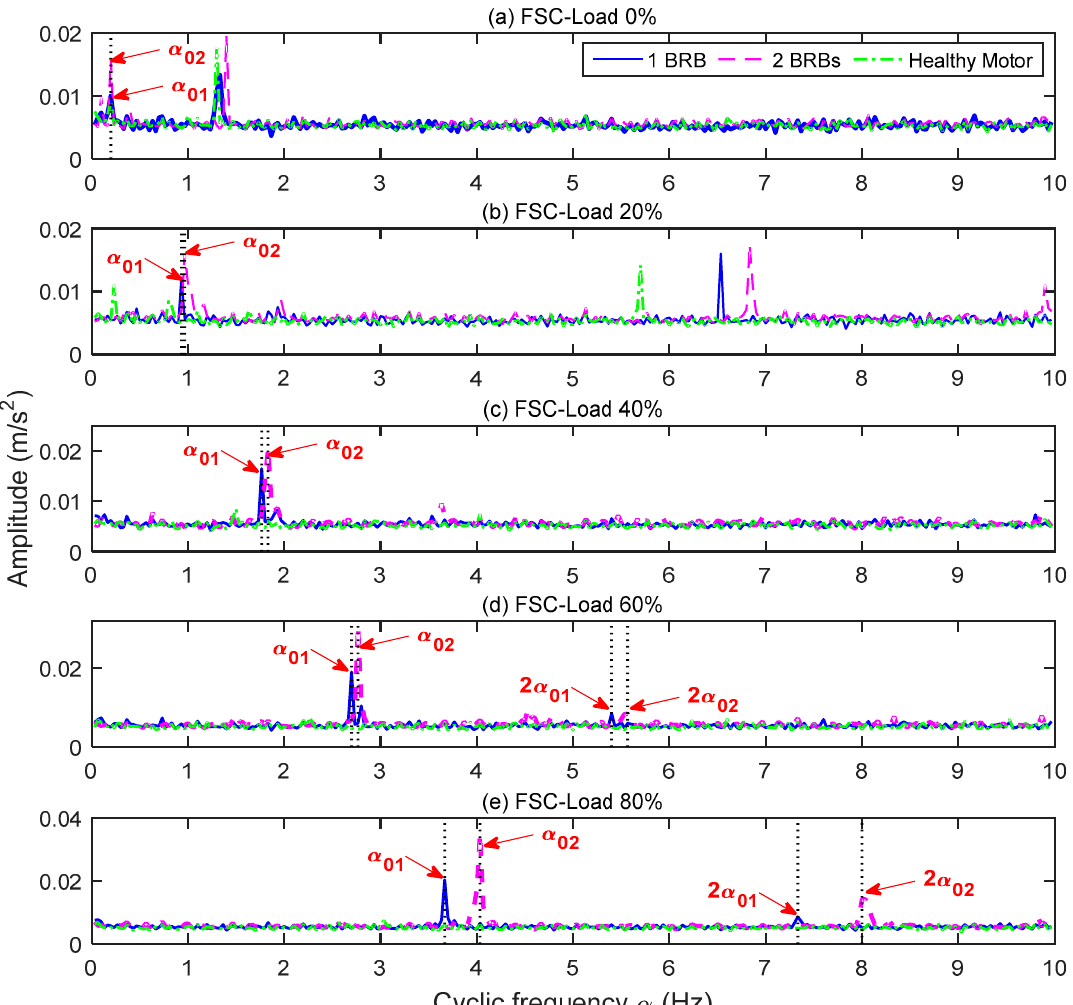
Figure 9. The characteristic frequencies of α 01 and α 02 for 1 BRB and 2 BRBs based on FSC method at ( a ) 0% load, ( b ) 20% load, ( c ) 40% load, ( d ) 60% load, and ( e ) 80% load under operating condition. Blue for 1 BRB, Pink for 2 BRBs, and Green under healthy motor.